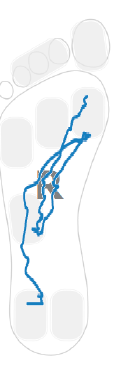
Figure 5. Sample distribution on both clusters.